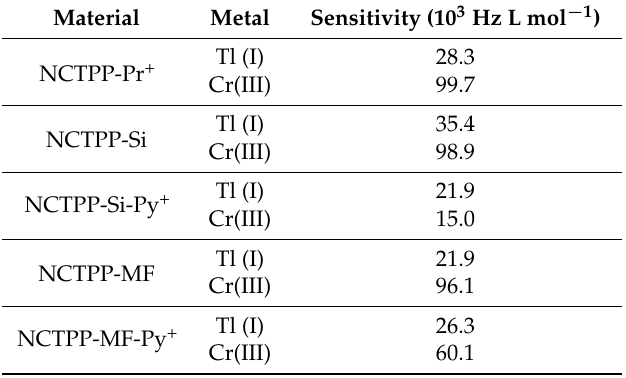
Table 1. Summary of all the sensors sensitivity for each